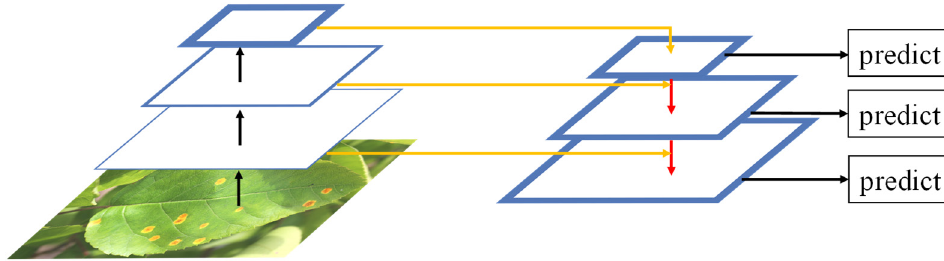
Figure 4. The building block of FPN. The black arrows, red arrows and yellow arrows imply convolution, upsampling and 1 × 1 convolution, respectively.